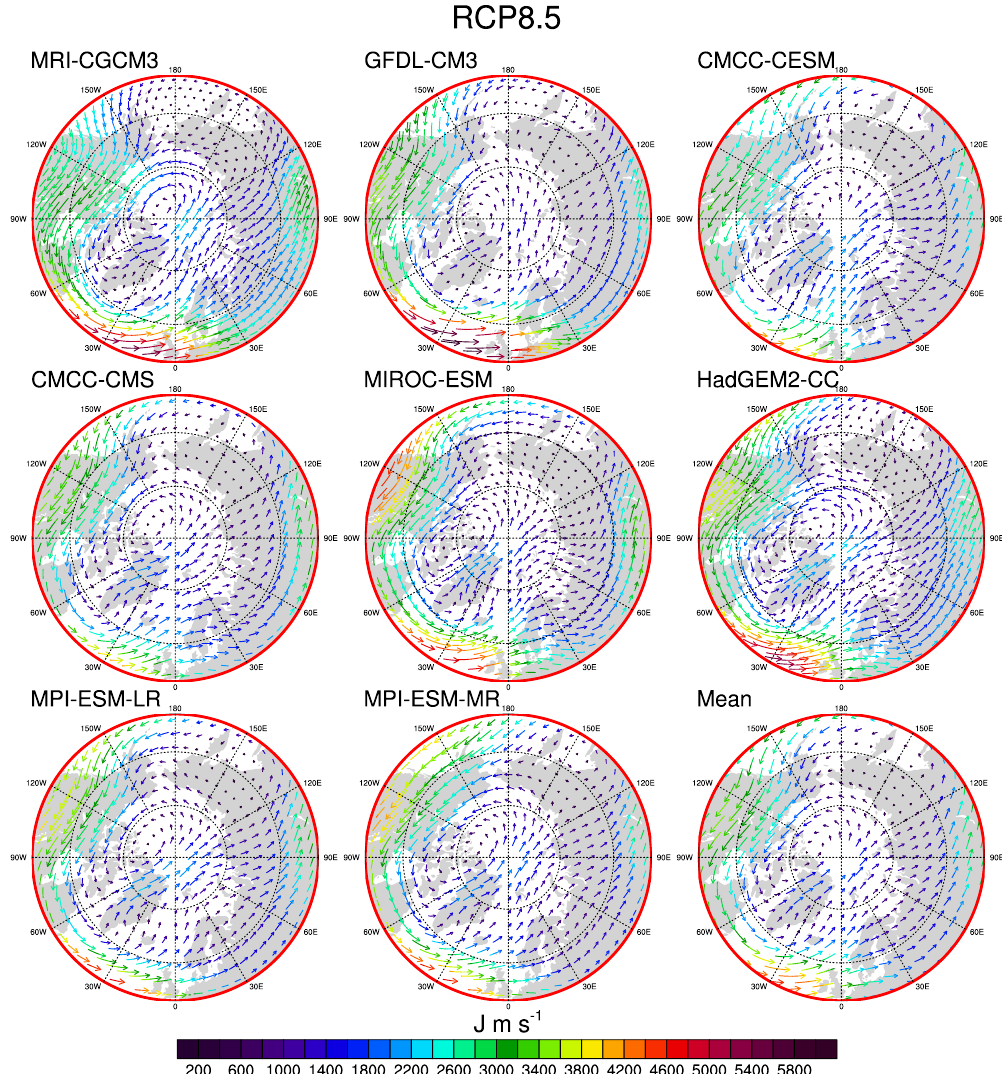
Figure 5. The Atlantic pathway for each of the analyzed models from Table1, derived based on the CMIP5 RCP8.5 data for the winters from 2050–2099. Colors and arrows show the amplitude and direction of the horizontal temperature flux at 500 hPa. The multi-model mean of all pathways is shown in the bottom-right